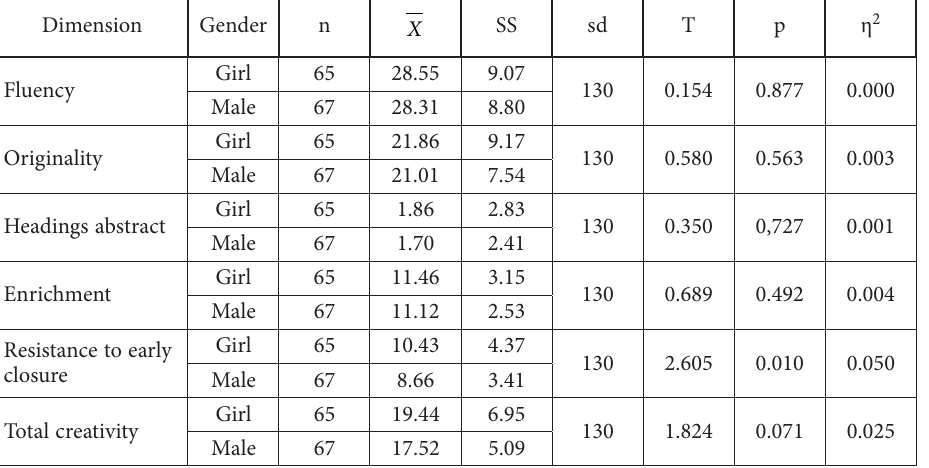
Table 8. Results of T-Test of creativity scores of children participating in the study in the eighth grade according to gender (source: created by author)